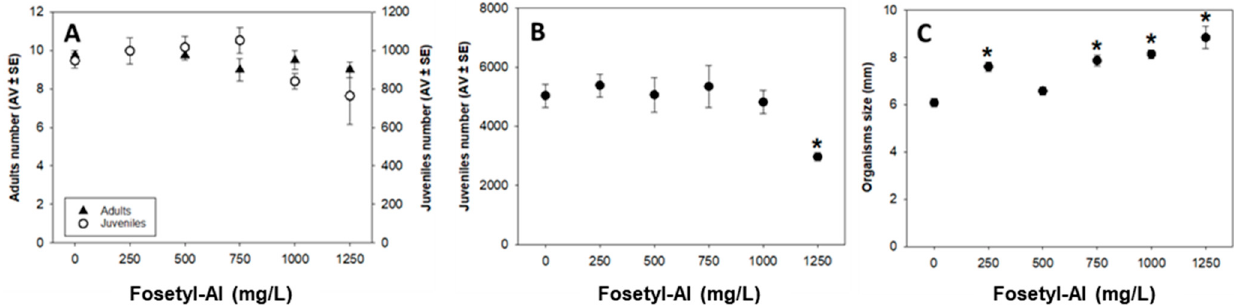
Figure 5. Effects of fosetyl-Al on Enchytraeus crypticus for survival (number of adults) and reproduction (number of juveniles) after 28 d of exposure ( A ); reproduction (number of juveniles) after 56 d of exposure ( B ); and adults’ sizes after 28 d of exposure ( C ). Data are expressed as average value (AV) ± standard error (SE). * Significant differences to control ( p < 0.05).